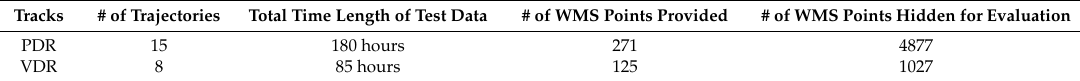
Table 4. Statistics of test data for the xDR Challenge. VDR: vehicle